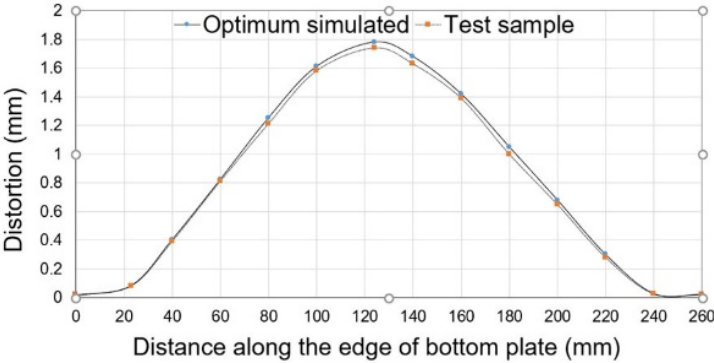
Figure 17. Test sample of optimum weld sequence. Figure 18. Comparison of optimum weld simulation with test sample.